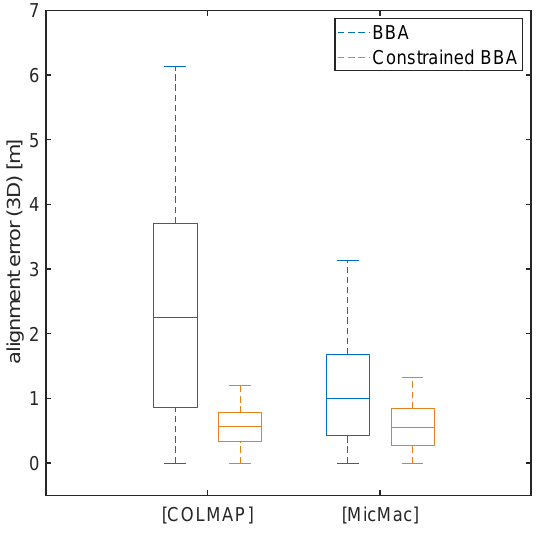
Figure 7. Stereopolis-Ladybug: boxplot of object-space errors provided by the two considered methods.